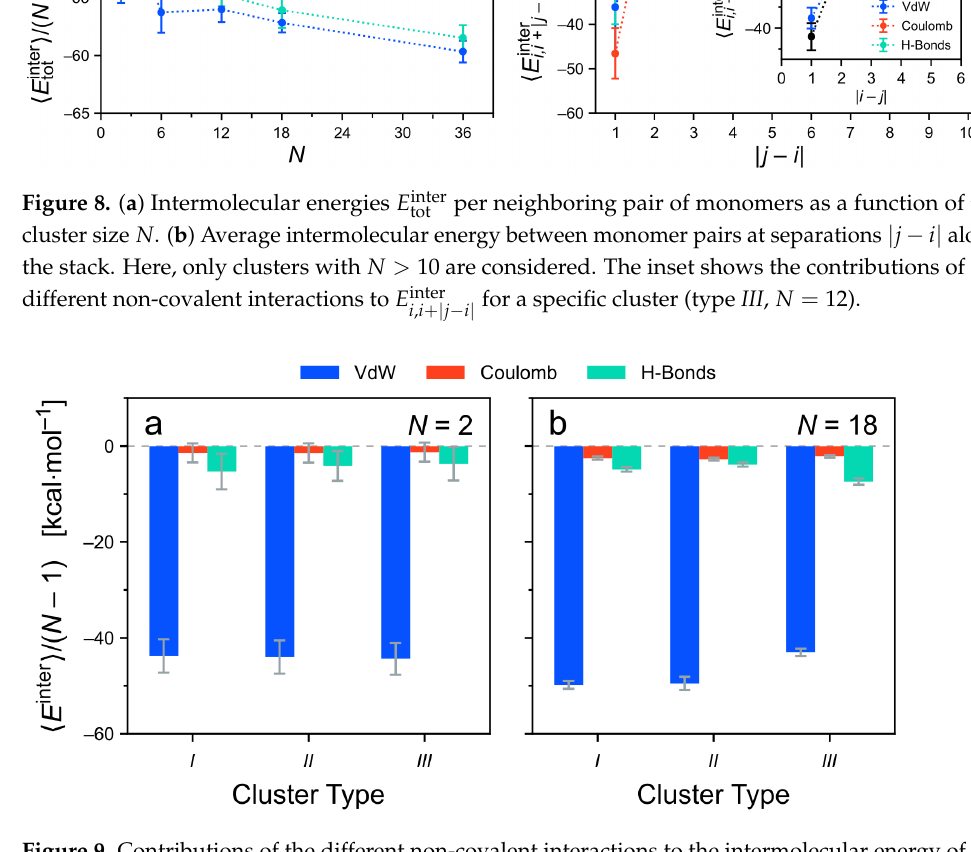
Figure 9. Contributions of the different non-covalent interactions to the intermolecular energy of the TrisAzo stacks. The energies are divided by the number of neighboring monomer pairs ( N − 1) for better comparability. Results for ( a ) N = 2 and ( b ) N = 18 are shown for each cluster